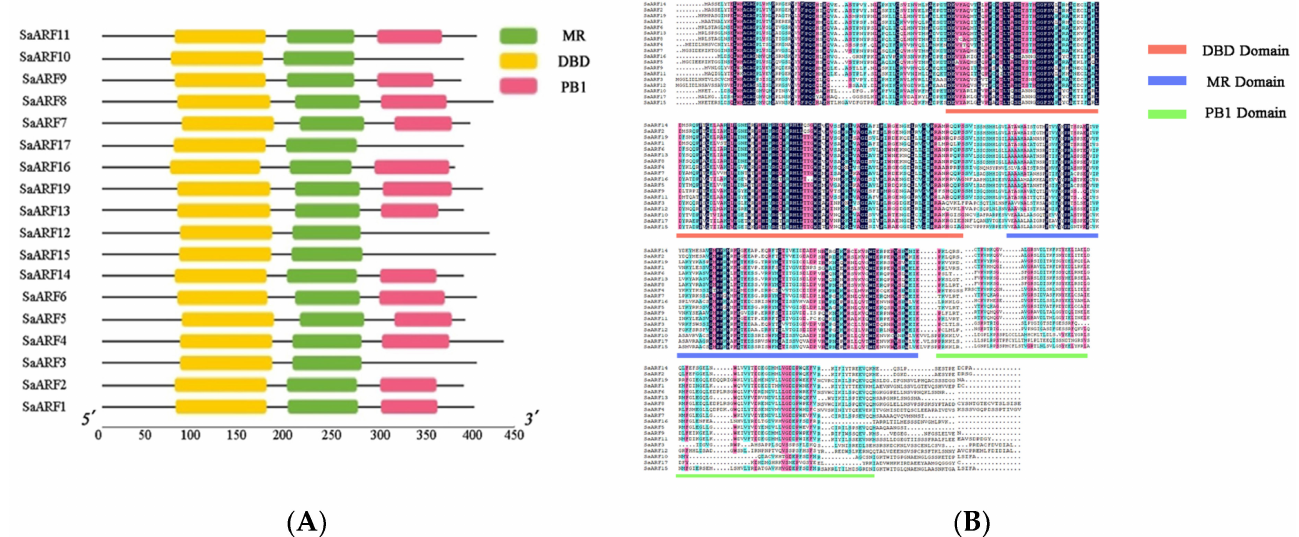
Figure 2. Multiple sequence comparison and conserved domain analysis of the SaARF gene family.